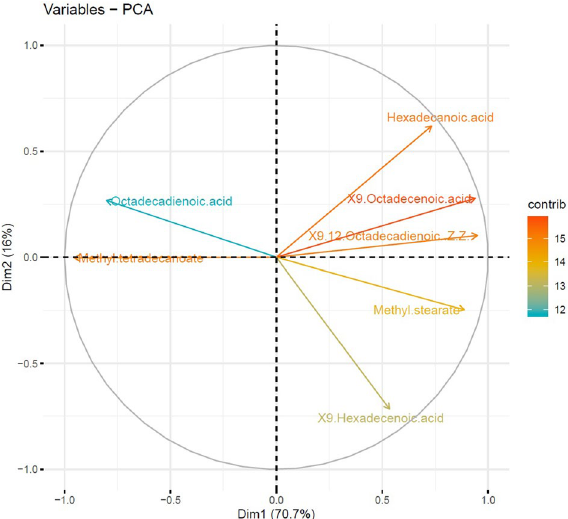
Figure 7. The PCA projection of individual metabolites on the correlation circle in photoperiodic induced diapause metabolite composition for fatty acids in P. interpunctella